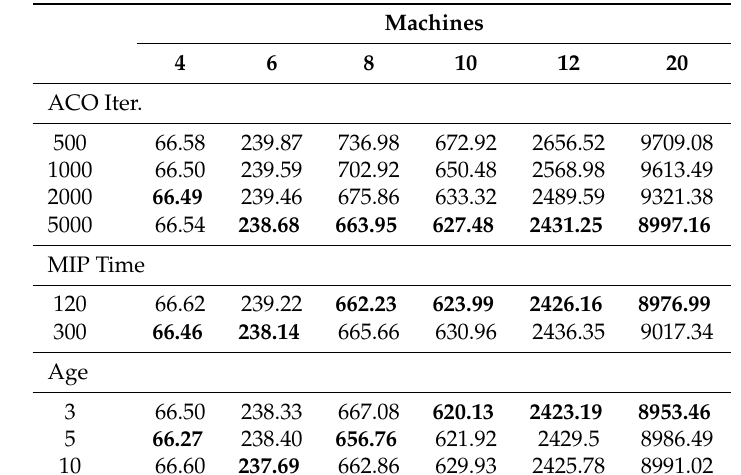
Table A2. The results of experiments conducted to determine which set of parameter values leads to the best performance of CMSA. For each parameter, the results are averaged across the results of all the settings for all other